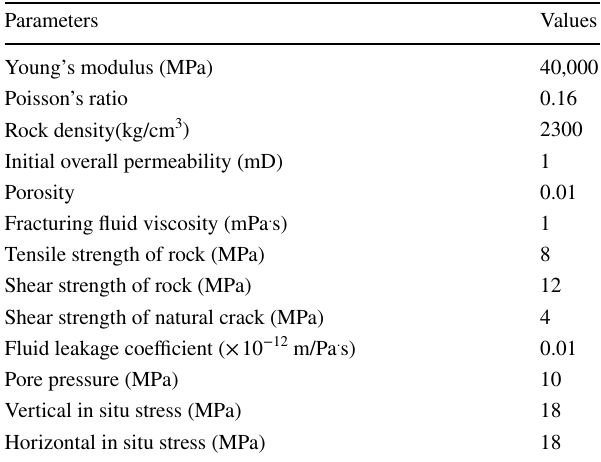
Table 2 Parameters used in simulation